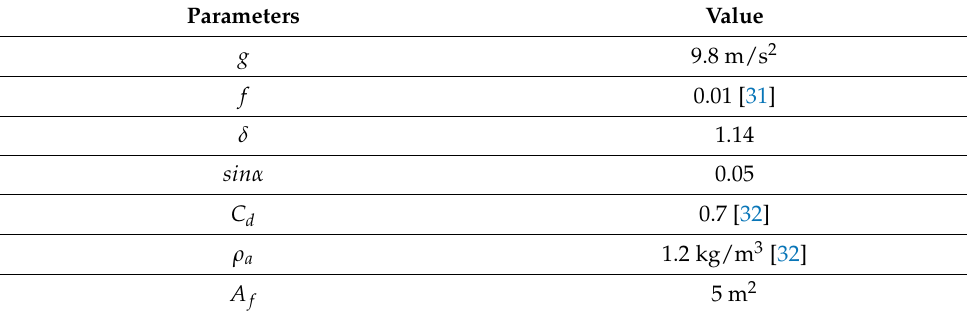
Table 7. Parameters of driving resistance.